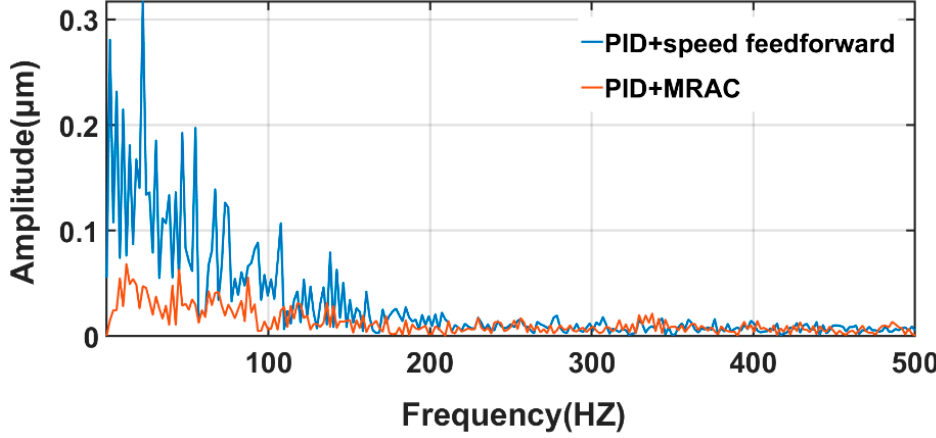
Figure 19. Comparison of following error of the two methods.